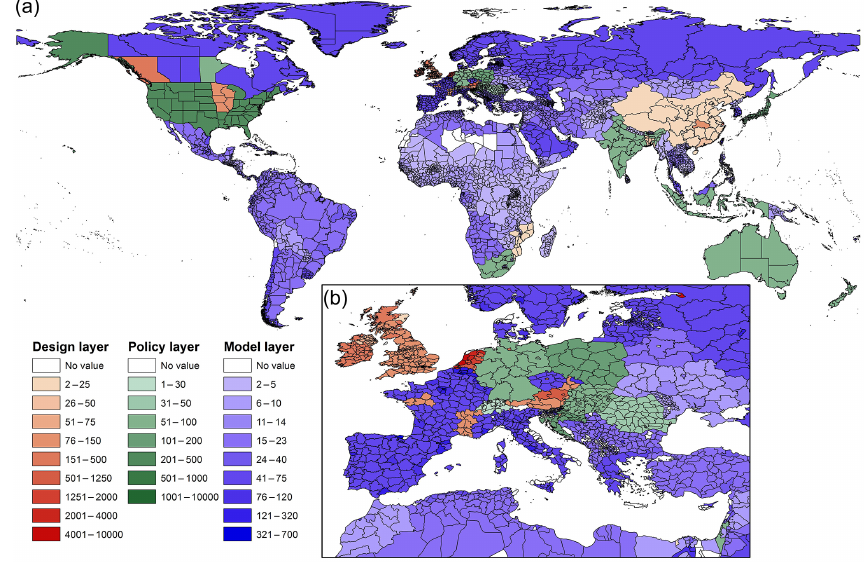
Figure 3. (a) World and (b) Europe maps of flood protection standards contained in the FLOPROS database, for sub-country administrative units (http://www.gadm.org). Standards of the design, policy and model layers (see Sect. 2) are indicated in the red, green and blue colour scales, respectively; these are integrated into the merged layer, which the maps ultimately represent. White indicates no data available (see Sect. 2.4). Note that only the protection standards of the design and policy layers that are coherent with the scale of the sub-country units are included, and therefore part of the information of FLOPROS is not represented in the maps.